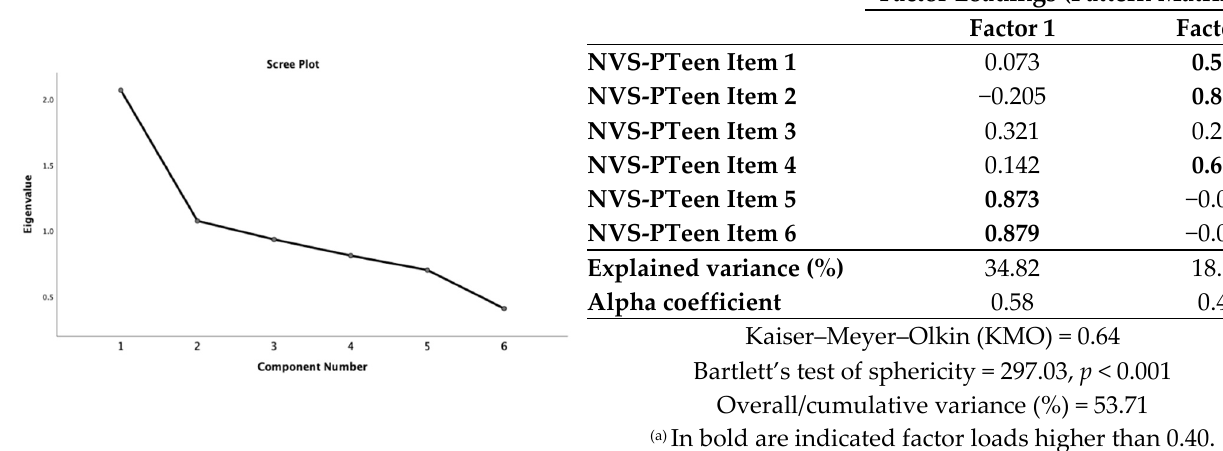
Figure 1. Exploratory factor analysis after direct oblimin rotation (with the screen test plot of eigenvalues) for the NVS-PTeen ( N = 386).